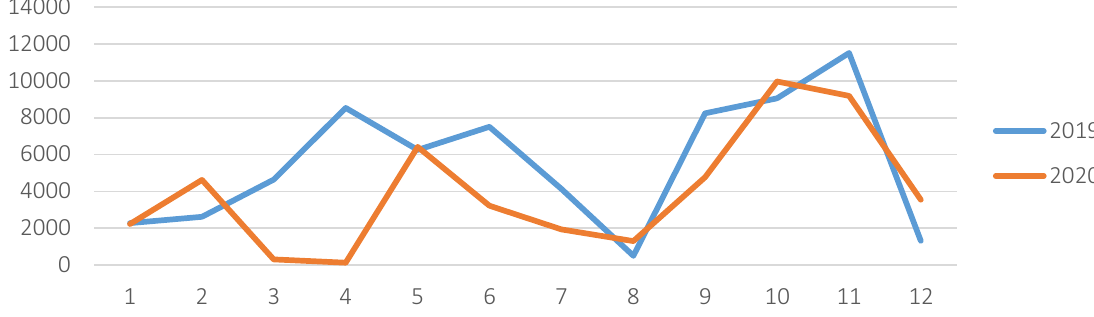
Figure 6. Monthly number of B2B meetings at brokerage events in 2019 and 2020 according to the EEN event calendar